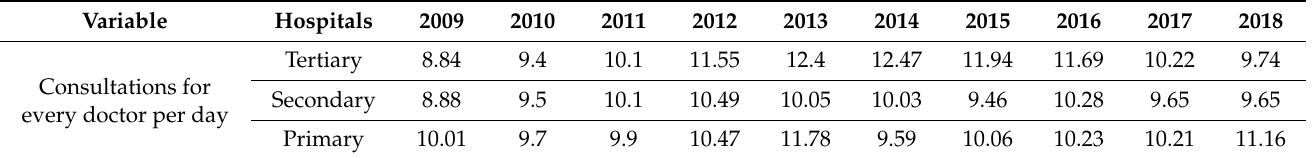
Table 2. Patients for every doctor per day of different level public hospitals in Beijing from 2009 to 2018 (Person-times).